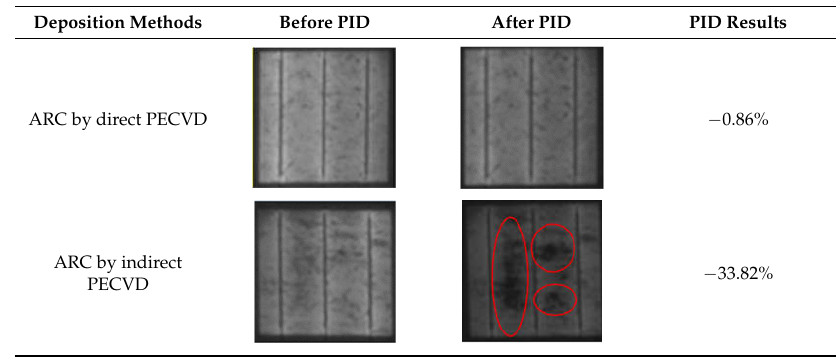
Table 2. The PID testing results and EL images for the solar cells with SiN x films deposited by the direct and indirect PECVD.